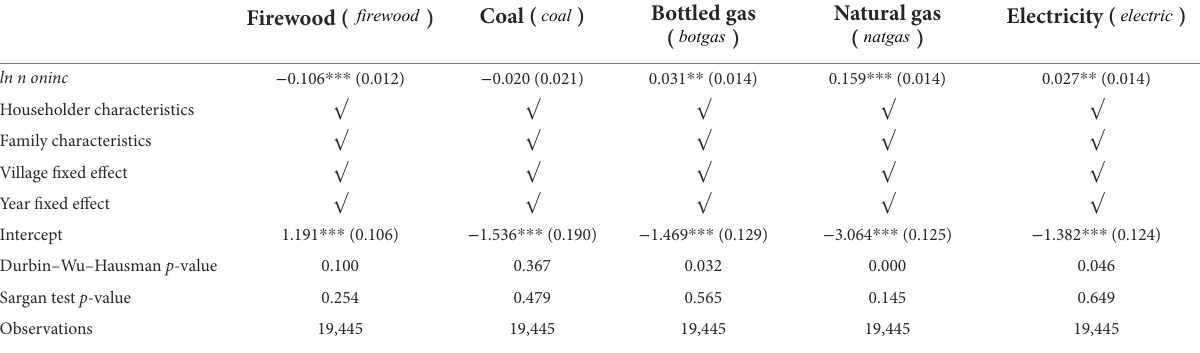
TABLE 5 Robustness Logit test regression